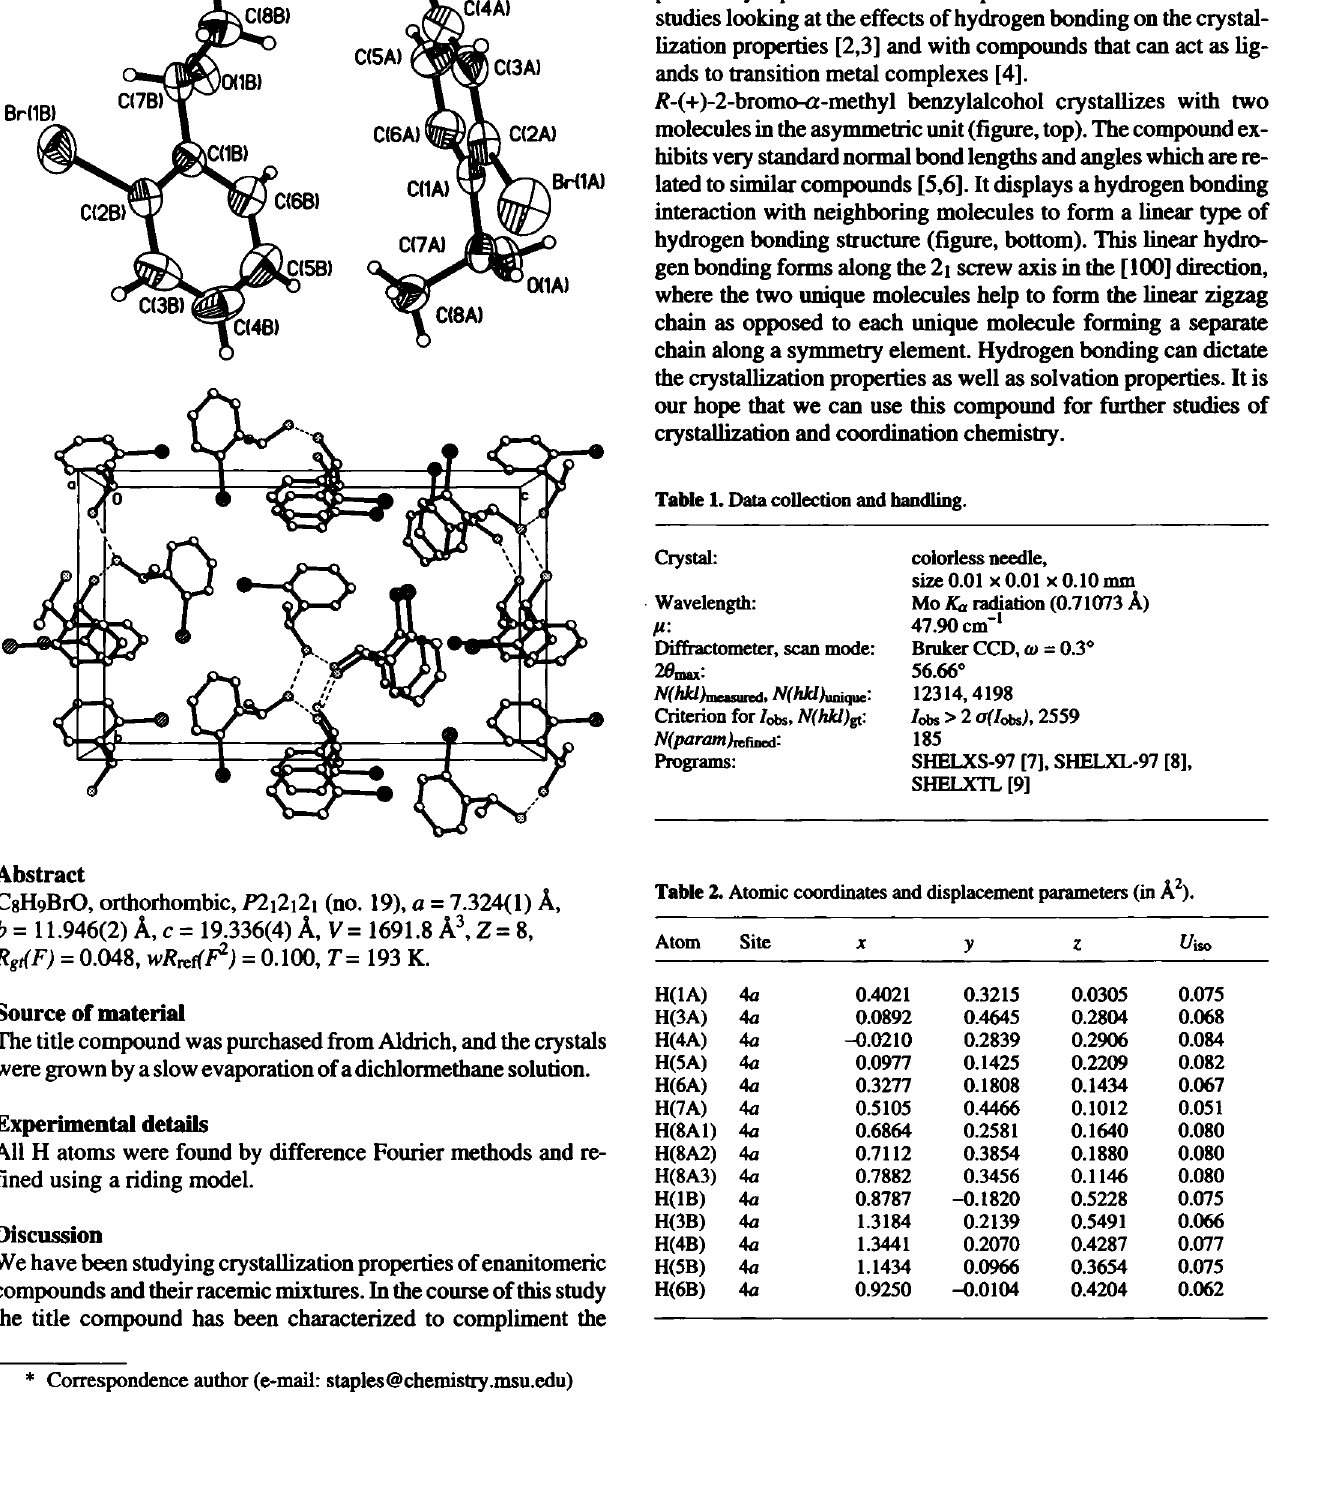
Table 2. Atomic coordinates and displacement parameters (in Â 2